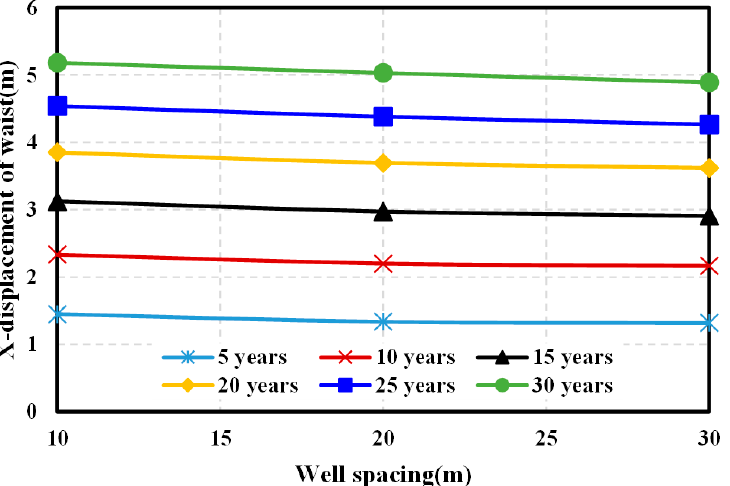
Figure 14. Displacement contours in X direction with different well spacings after operating for 30